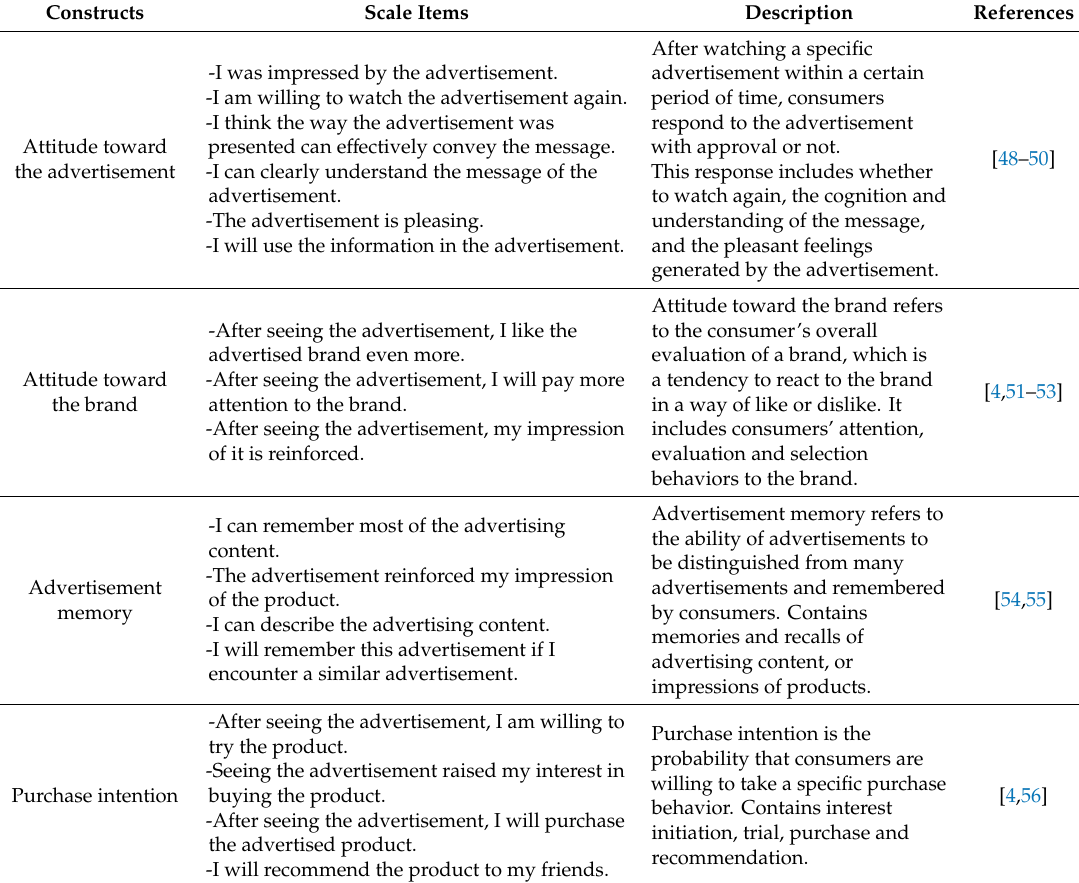
Table 1. Users’ advertising e ff ectiveness